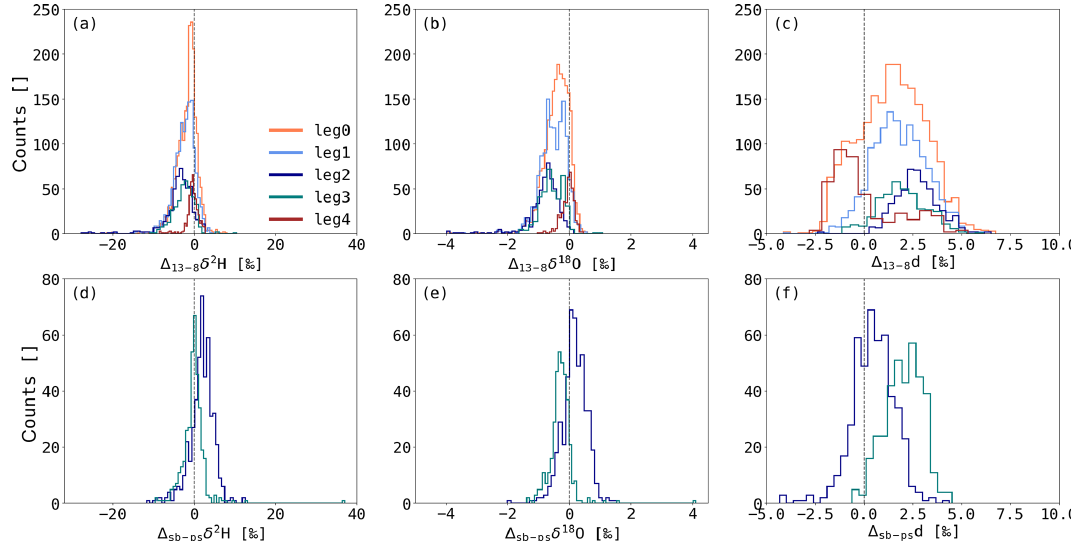
Figure A1. Histograms of difference between SWI-13 and SWI-8-ps (a–c) and SWI-8-sb and SWI-8-ps (d–f) for δ 2 H, δ 18 O and d . The histograms are coloured by legs. SWI-8-sb is only available for legs 2 and 3.